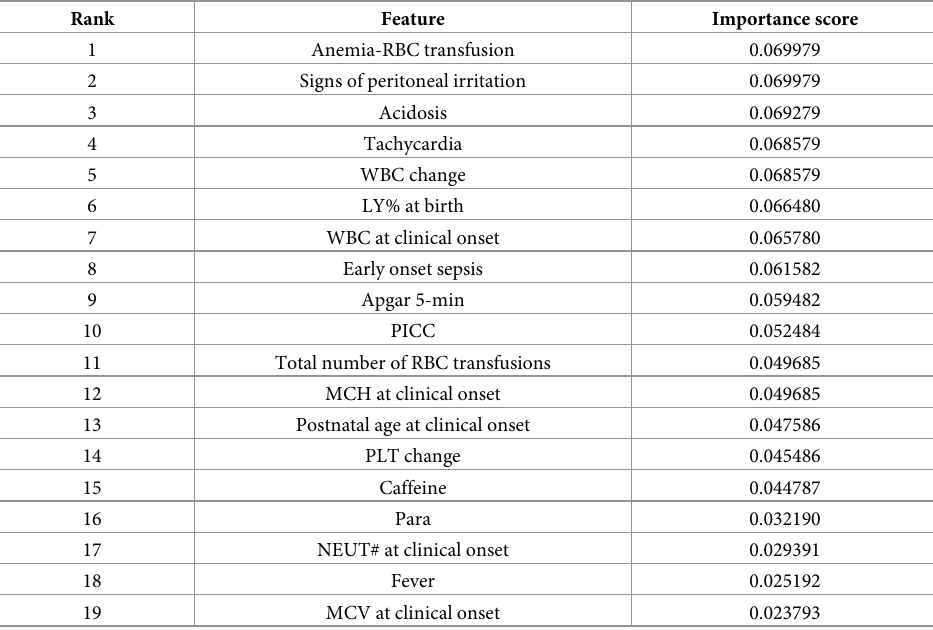
Table 6. Feature importance ranking of dataset